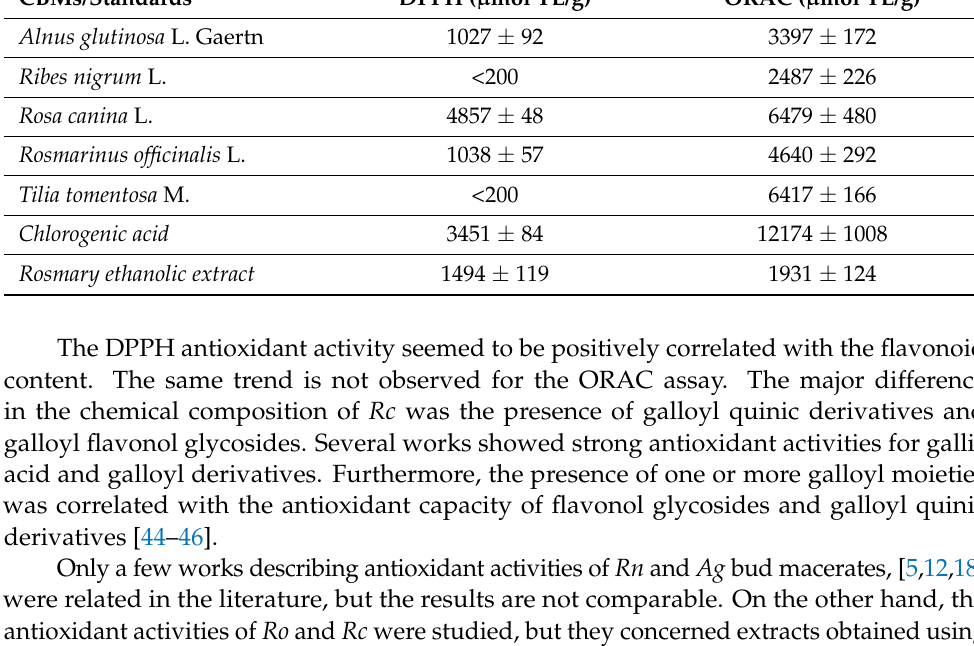
Table 4. Evaluation of the antioxidant activity of the five CBMs using DDPH and ORAC assays ( n = 3). CBMs/Standards DPPH ( µ mol TE/g) ORAC ( µ mol TE/g) Alnus glutinosa L. Gaertn 1027 ± 92 3397 ± 172 Ribes nigrum L. <200 2487 ± 226 Rosa canina L. 4857 ± 48 6479 ± 480 Rosmarinus officinalis L. 1038 ± 57 4640 ± 292 Tilia tomentosa M. <200 6417 ± 166 Chlorogenic acid 3451 ± 84 12174 ± 1008 Rosmary ethanolic extract 1494 ± 119 1931 ±